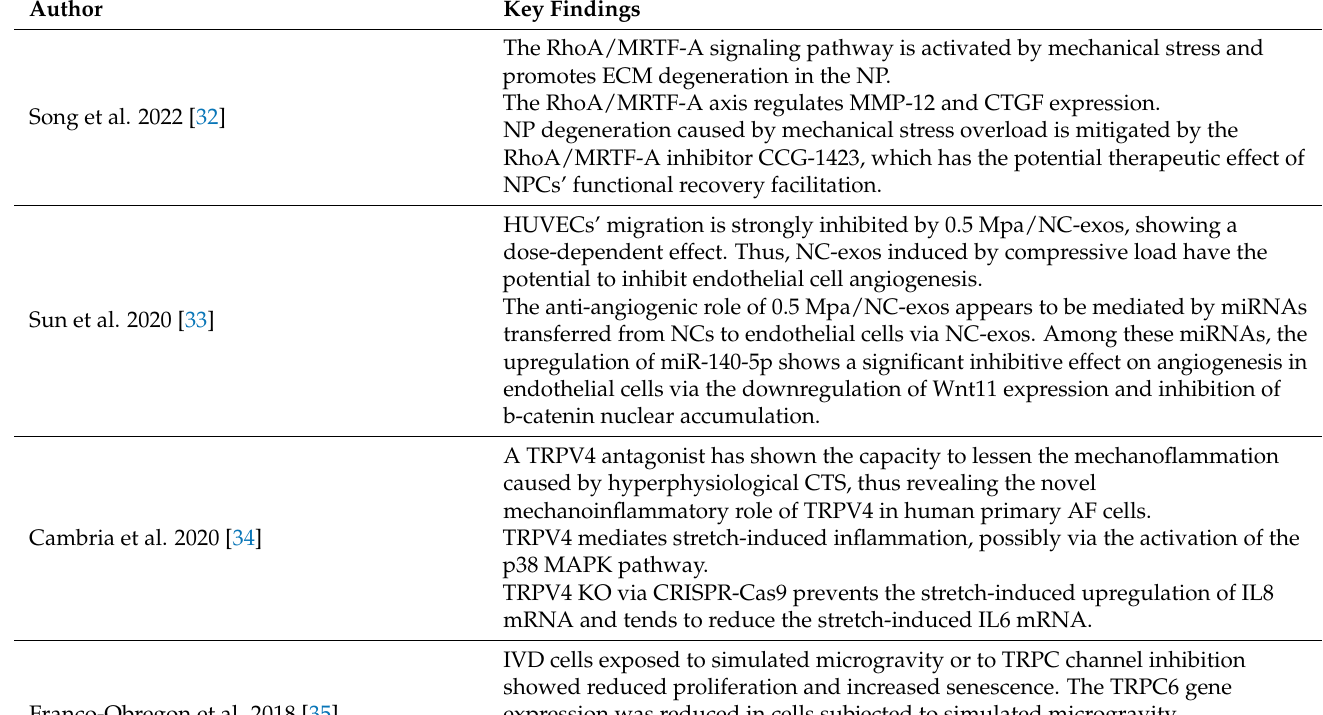
Table 2. Key findings of the included